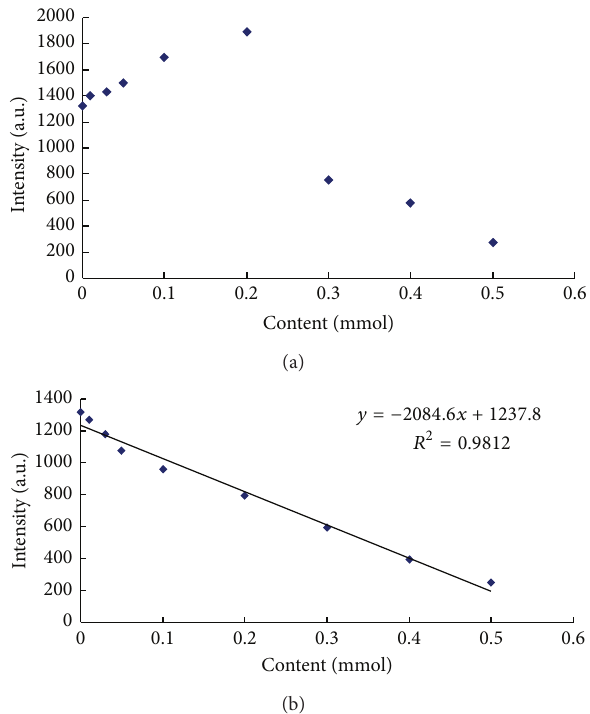
Figure 6: Effect of the different contents of La 3+ (a) and Gd 3+ (b) on the luminescent properties of the red-emitting